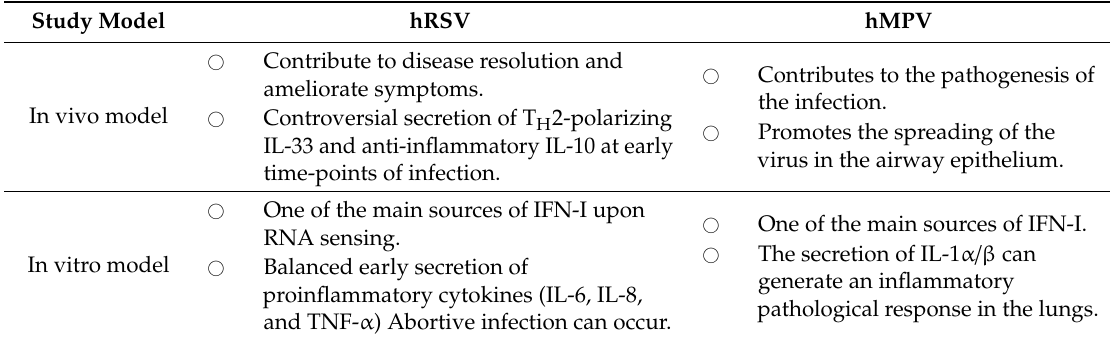
Table 2. Role of AMs in the pathology caused by hRSV and